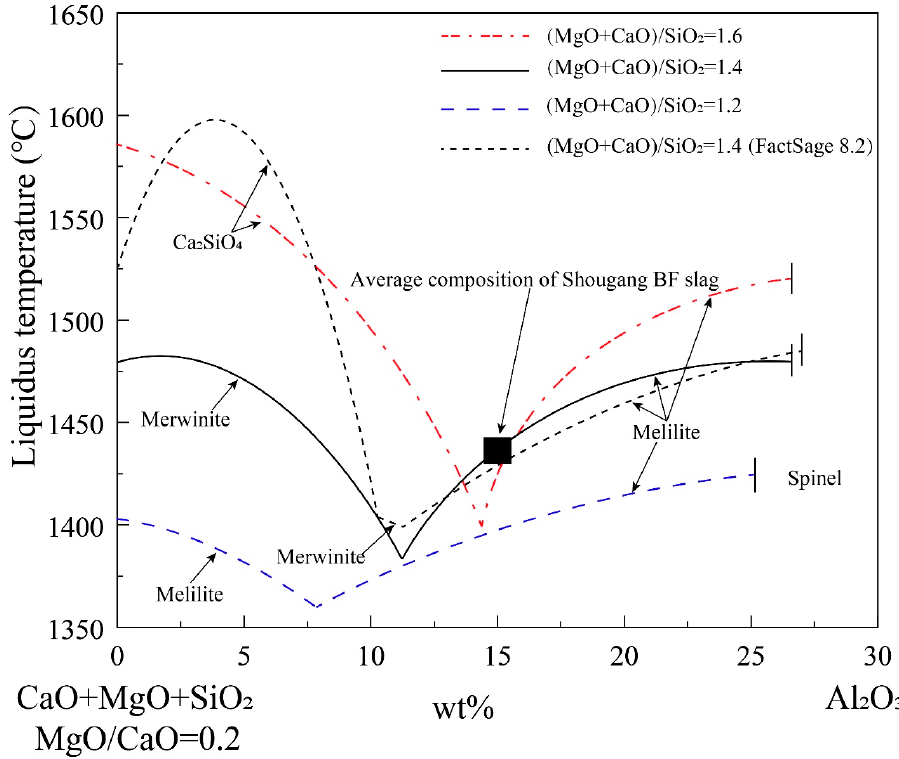
Figure 19. Liquidus temperature as a function of Al 2 O 3 concentration at fixed ternary basicity (MgO + CaO)/SiO 2 = 1.2 , 1.4 and 1.6 [23].